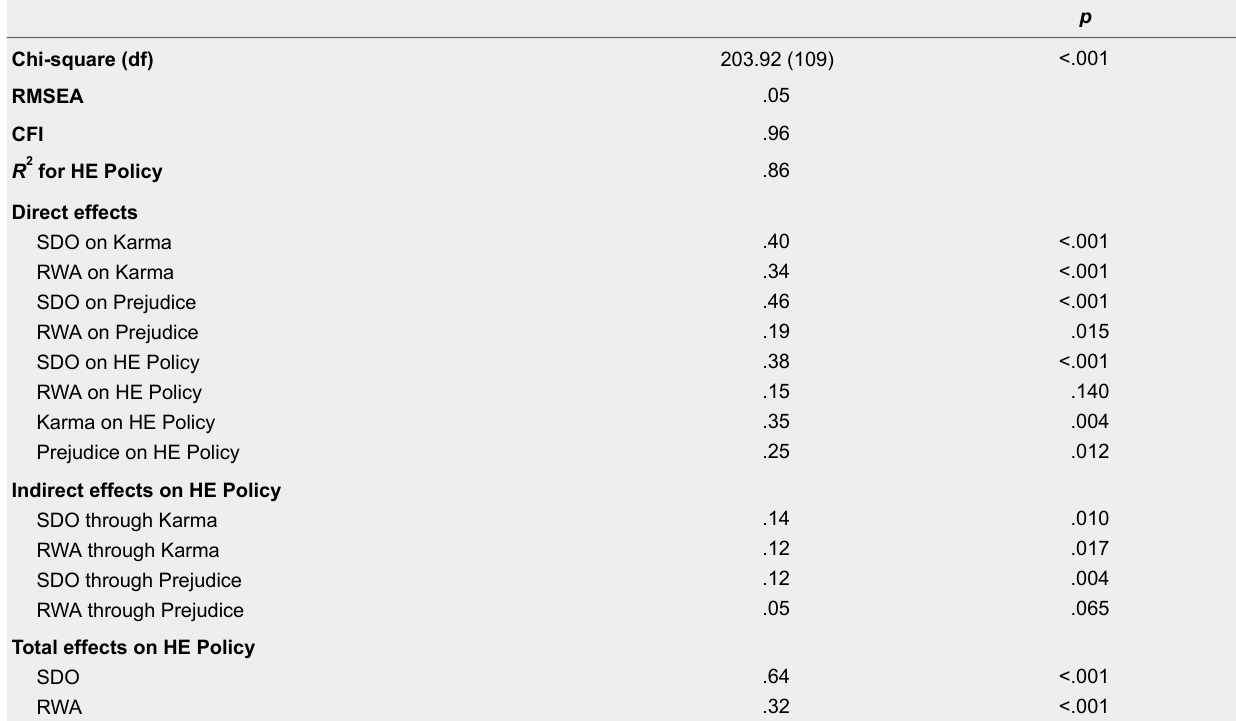
Model Fit Indices and Structural Equation